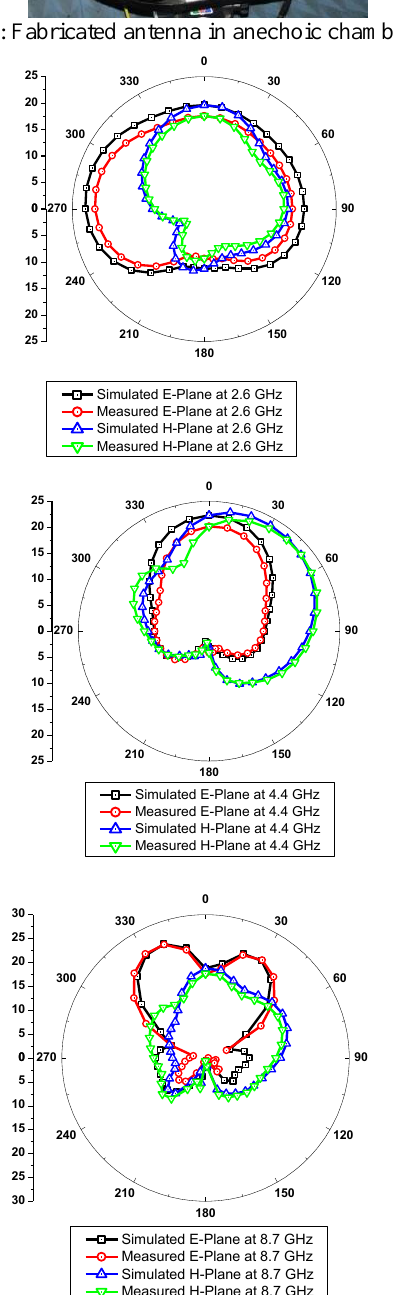
Simulated E-Plane at 8.7 GHz Measured E-Plane at 8.7 GHz Simulated H-Plane at 8.7 GHz Measured H-Plane at 8.7 GHz Figure 9: Simulated and Measured Radiation Pattern of the proposed